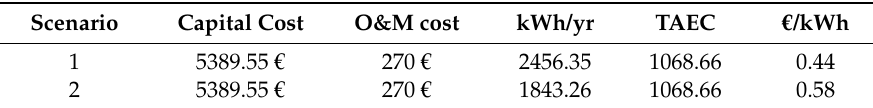
Table 2. Cost per kWh for the two examined